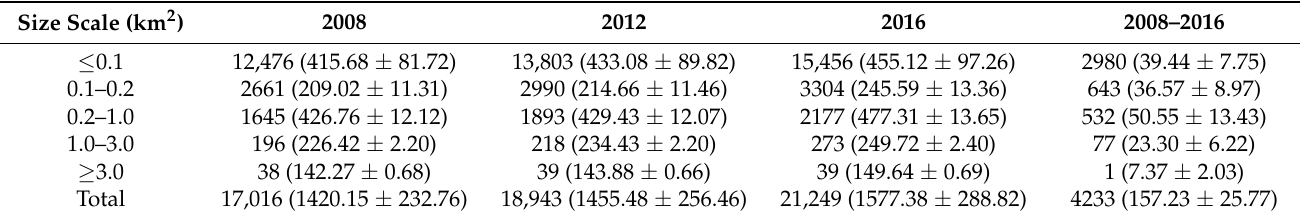
Table 1. Distribution of glacial lakes by number and area for 2008, 2012, and 2016 for five size classes. The values inside the brackets are the corresponding area (km 2